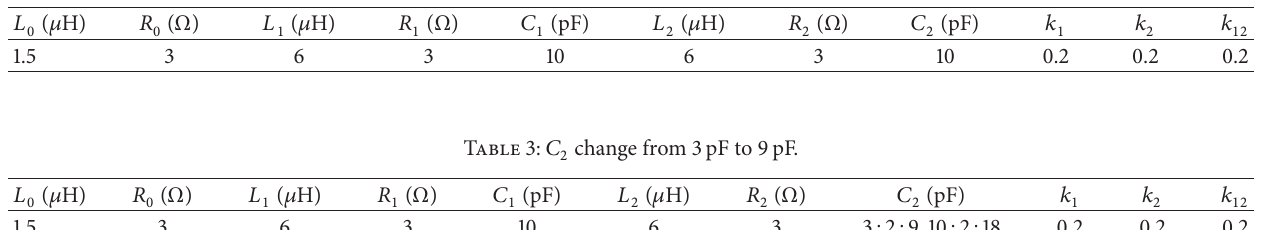
Table 2: Initial values for the antenna and for the two LC circuits.